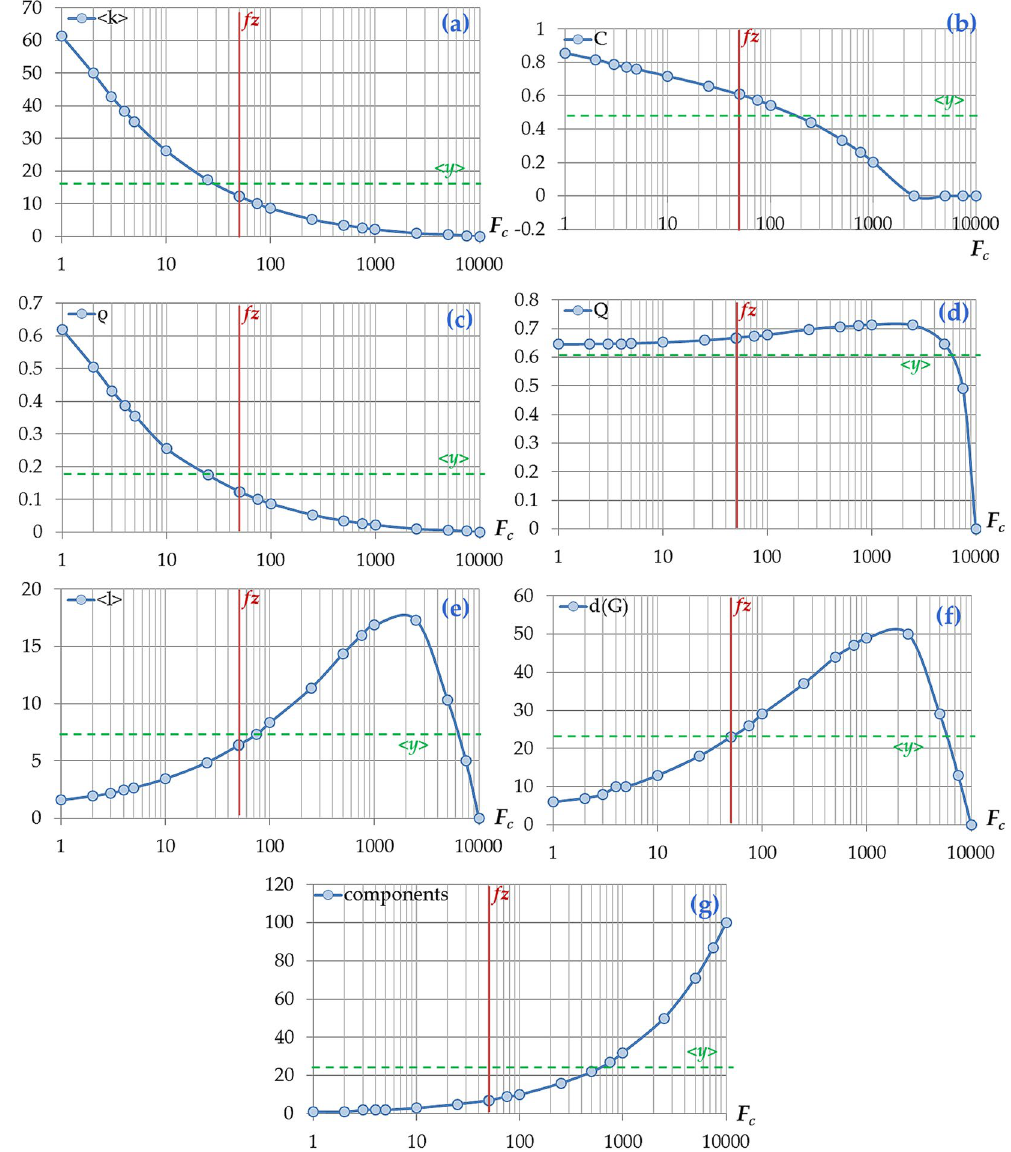
k , ( b ) clustering (cid:31) (cid:30) l , ( f ) network diameter d( G ), and (cid:31) (cid:30) [0, max{ X 1:100 } 2 ]. The bold vertical line represents the typical value f z ∈